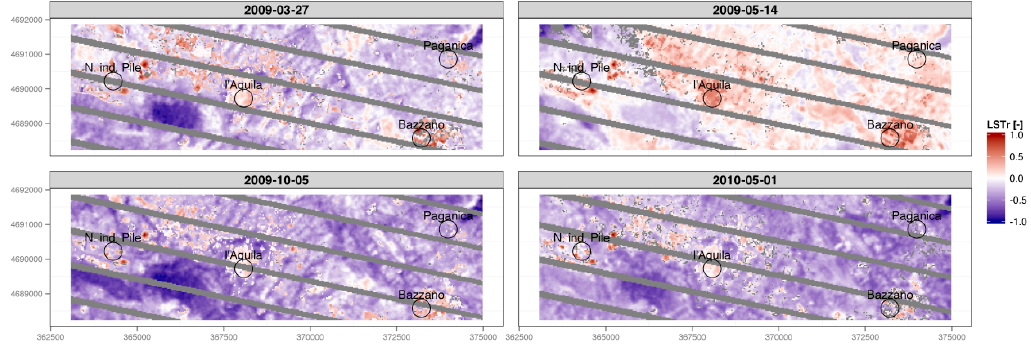
Figure 9. Land Surface Temperature Maps with rescale applied (LSTr). The gray pixels correspond to